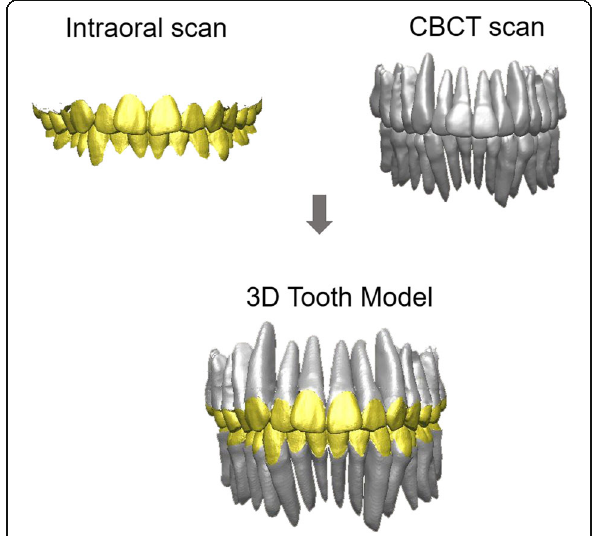
Fig. 3 The concept of this method using a 3D tooth